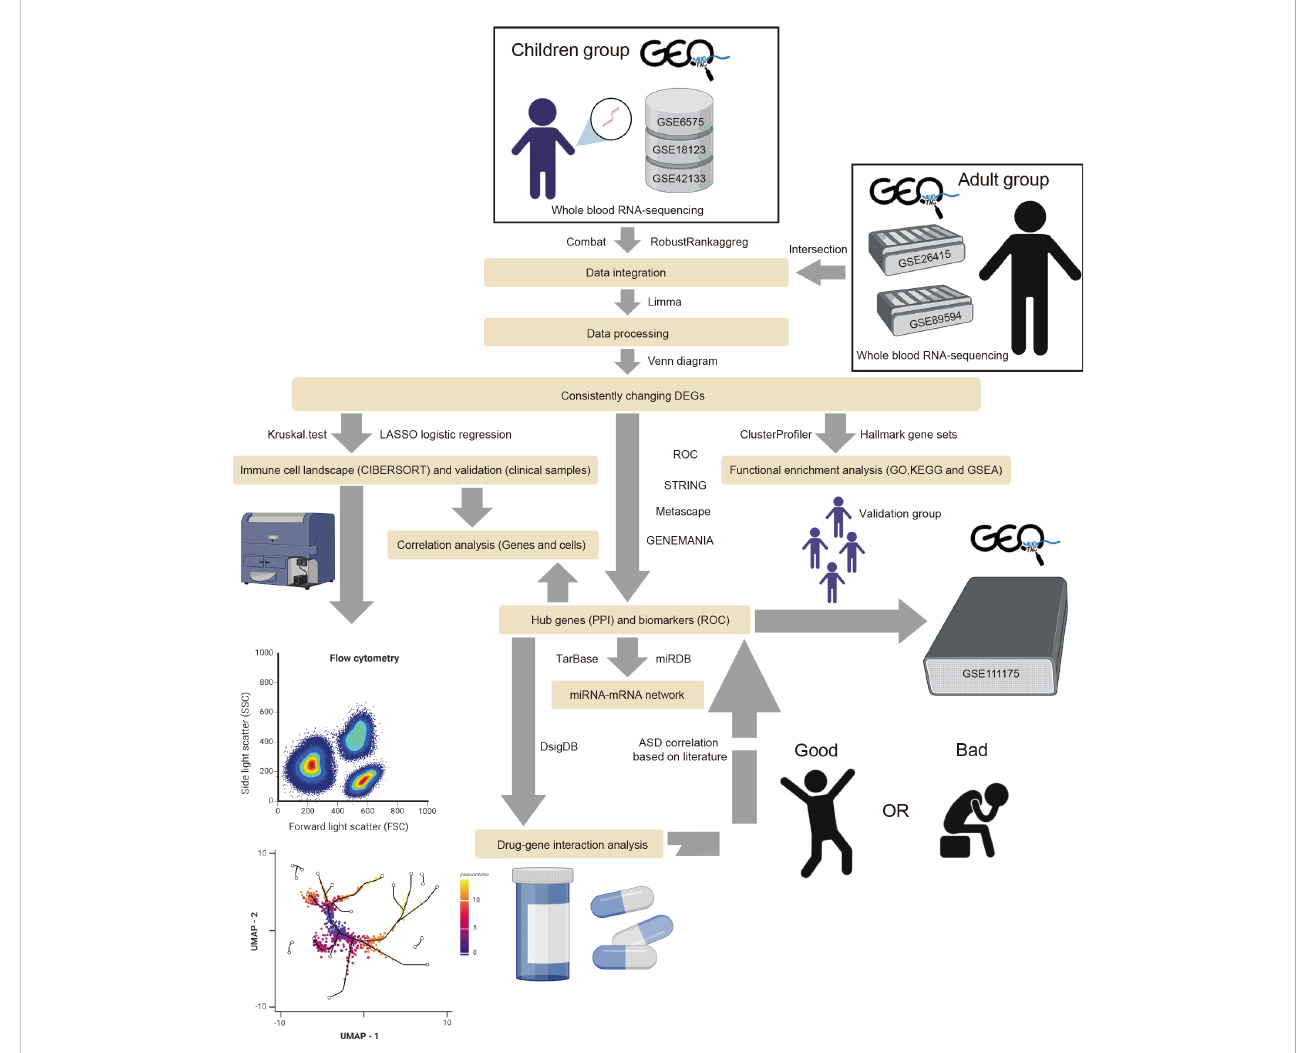
FIGURE 1 The fl ow diagram of the study. The adult group (GSE26415 and GSE89594) was only analyzed regarding GO, KEGG, GSEA, and immune cell in fi